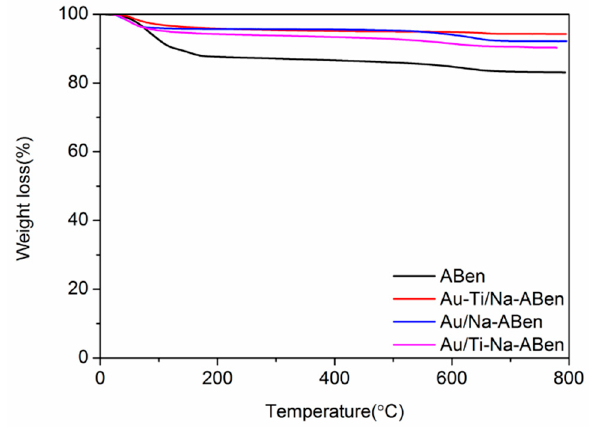
Figure 4. Thermogravimetrc analysis (TGA) curves of ABen, Au-Ti/Na-ABen, Au/Na-Aben, and Au/Ti-Na-ABen in an air atmosphere.